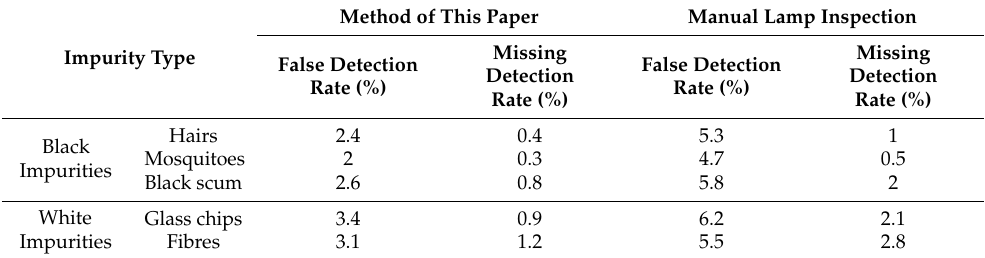
Table 4. Experiment results of different types of impurities.